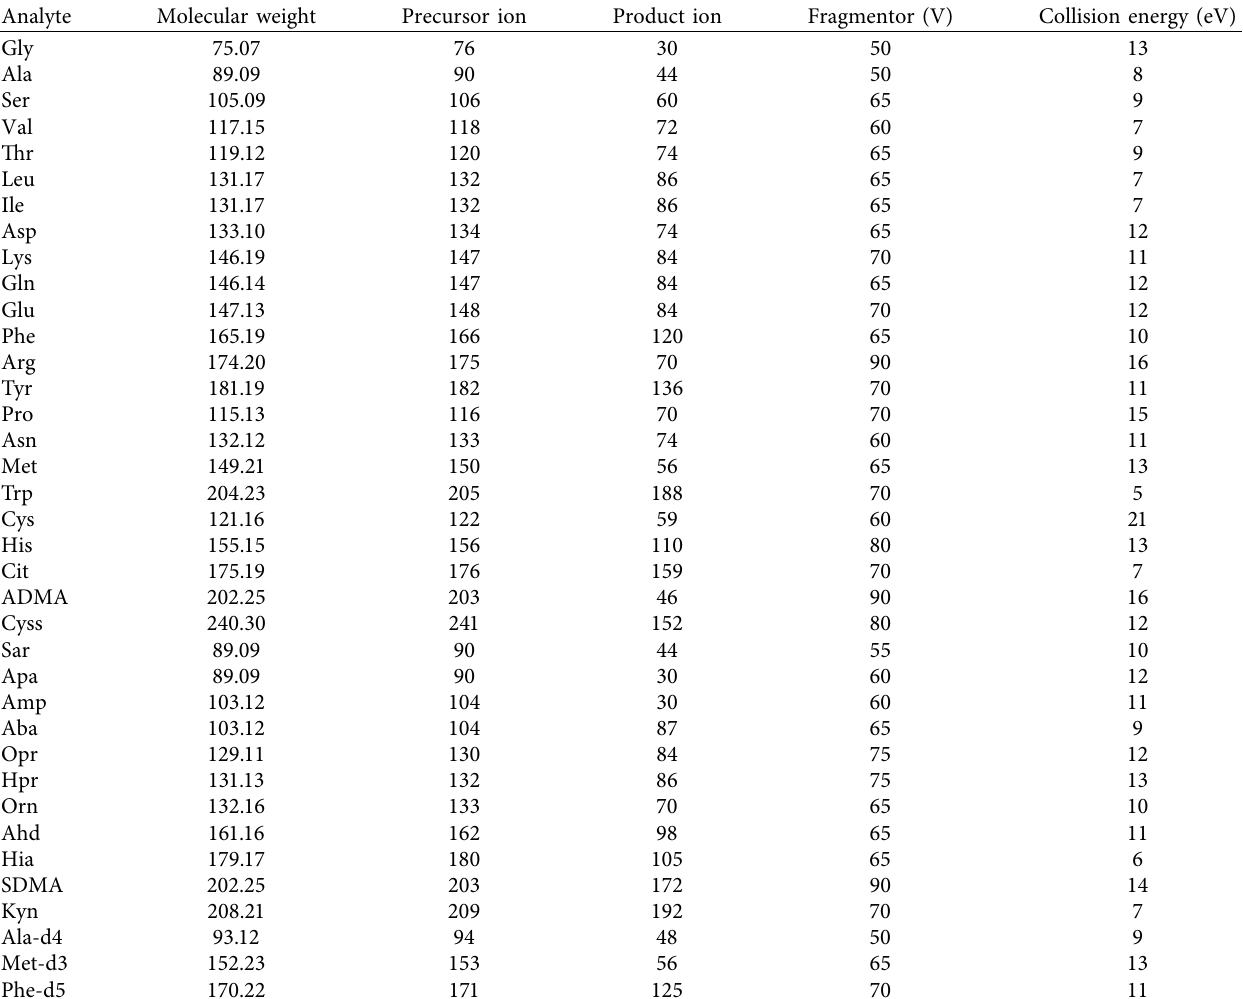
Table 2: The optimized MRM parameters of 34 amino acids and 3 ISs (ESI